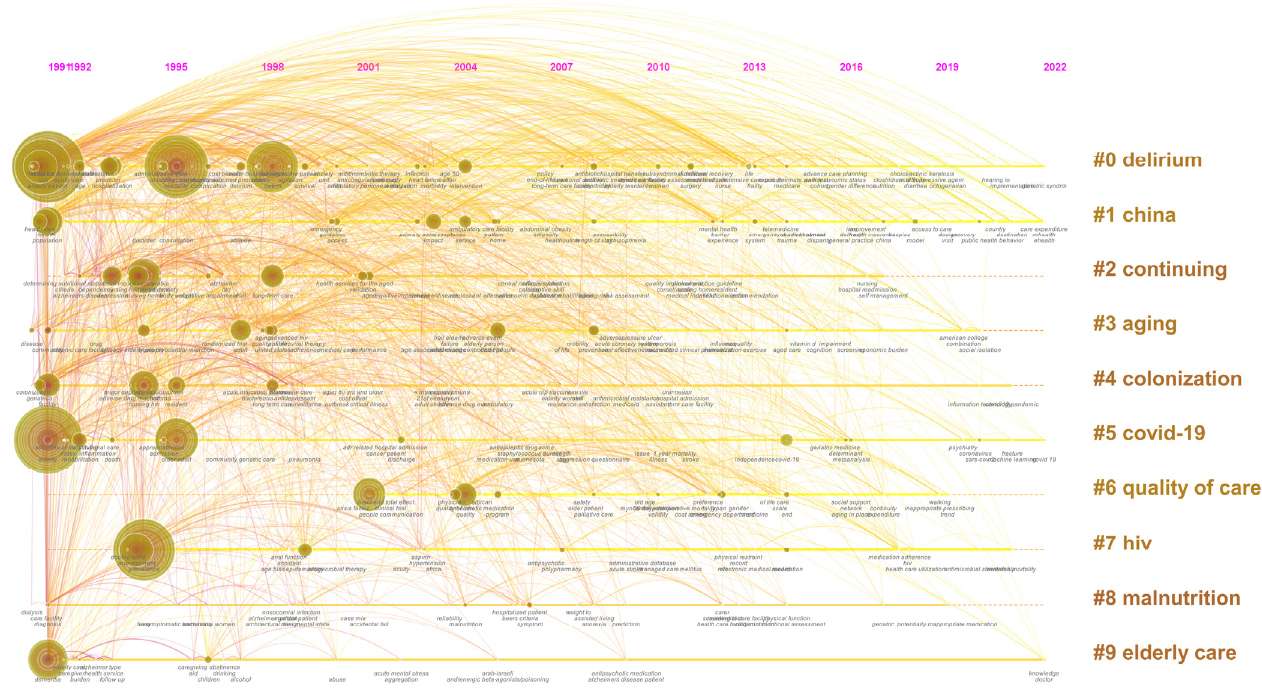
Figure 12. FCMNCE research time-zoned axial map (top 10 categories).